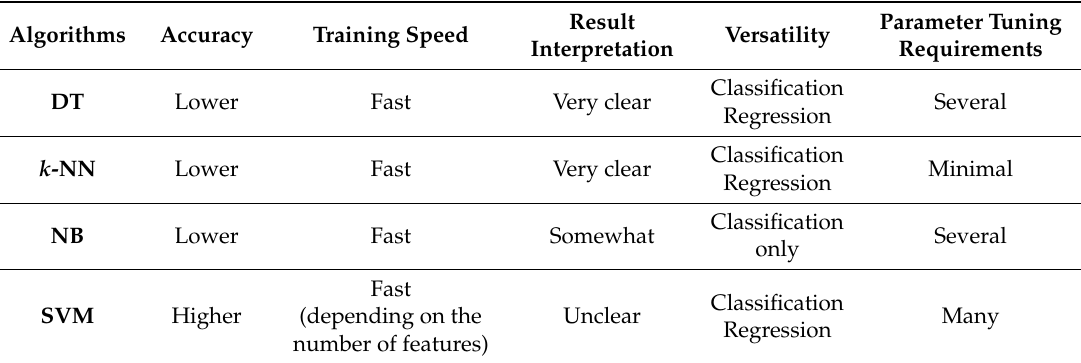
Table 2. Advantages and drawbacks of each